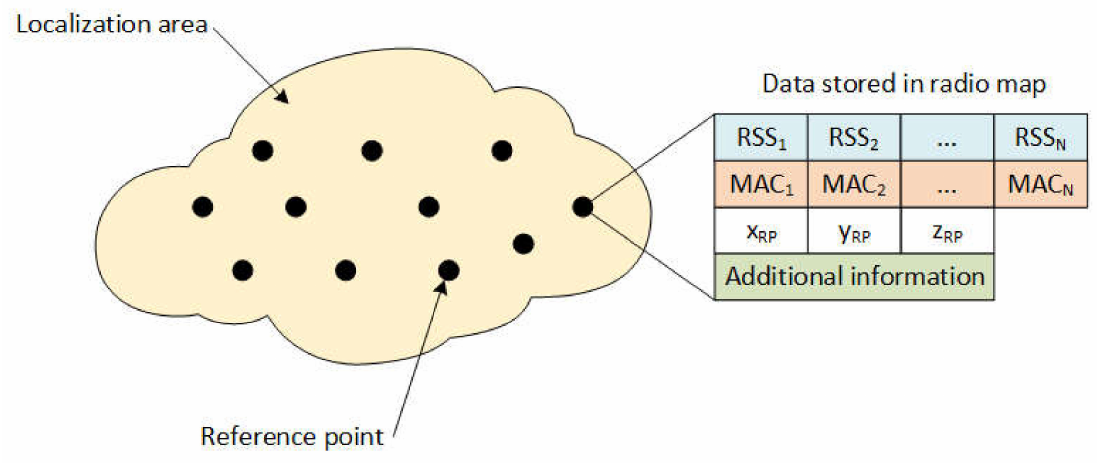
Figure 1. Principle of the radio